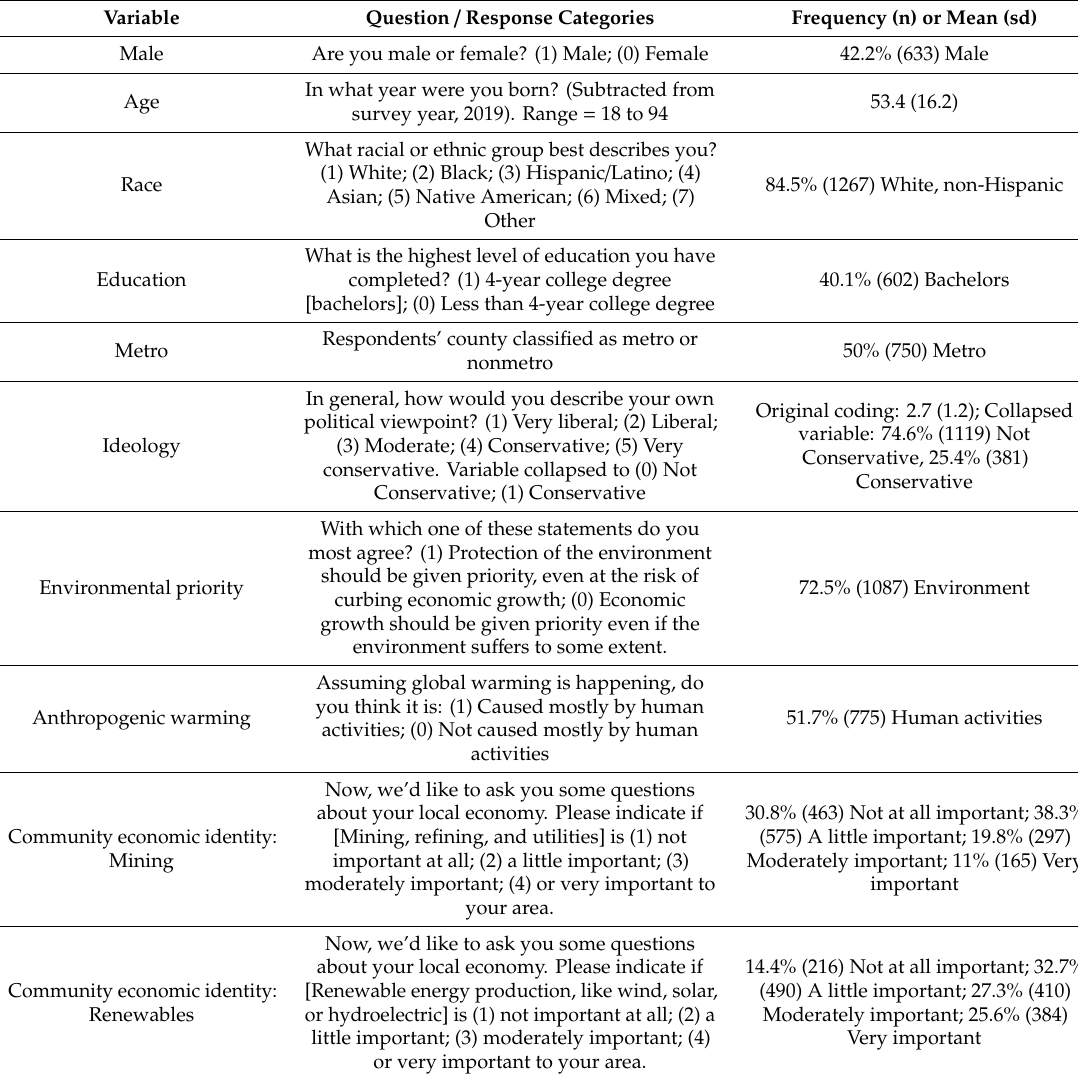
Table 1. Descriptive statistics for independent variables (n =